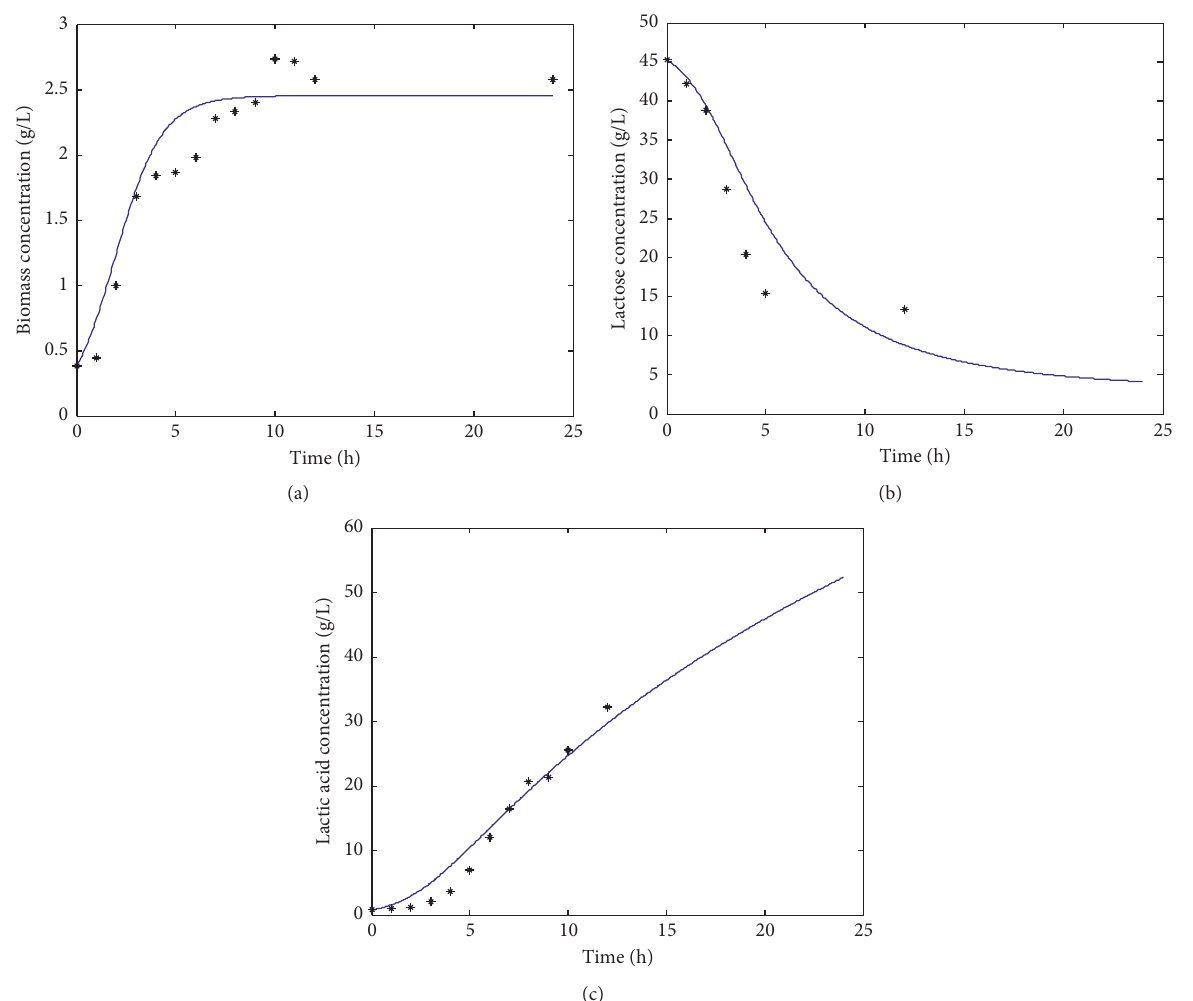
Figure 2: Experimental data (points) and simulation (lines) of biomass (a), lactose (b), and lactic acid (c) concentrations of 2L bioreactor batch culture of Enterococcus faecalis SLT13 on hydrolyzed cheese